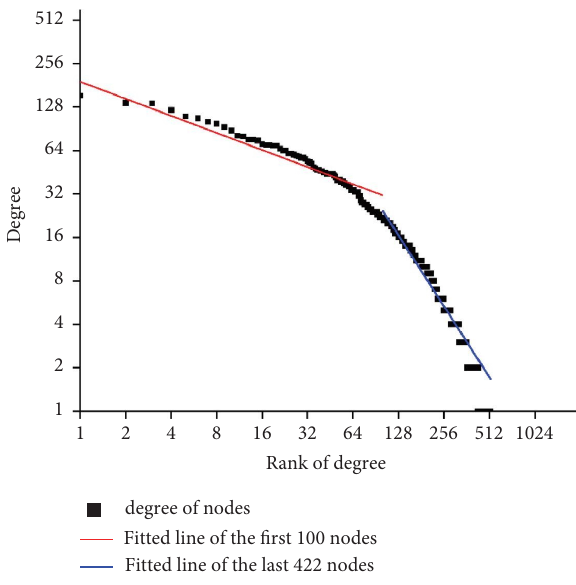
Figure 2: Degree distribution